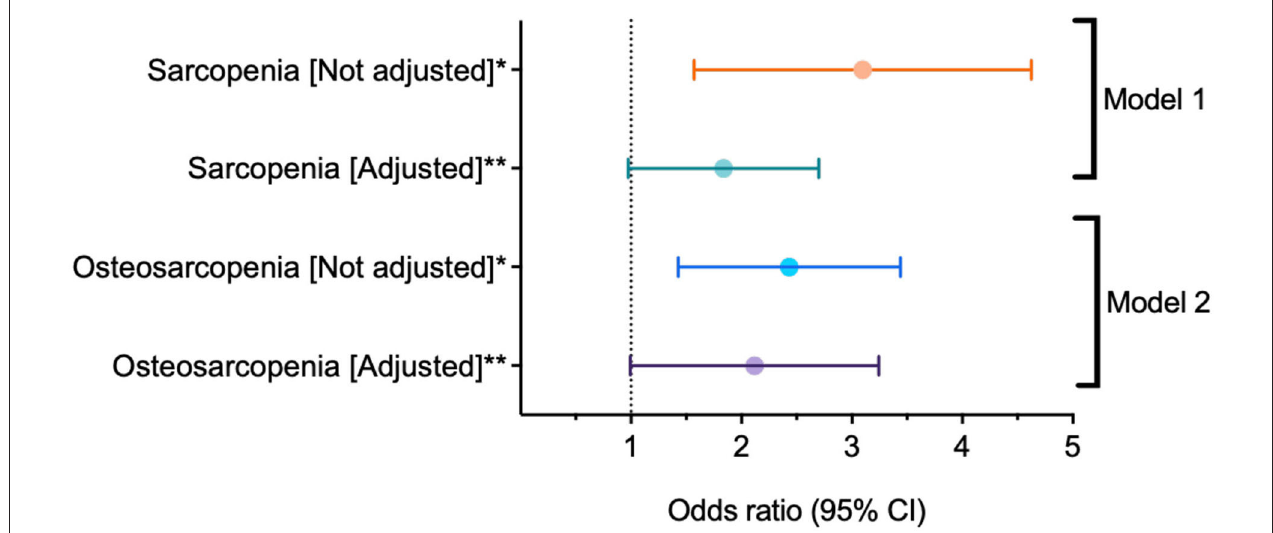
FIGURE 2 | Logistic regression between sarcopenia, osteosarcopenia, and functional disability. CI, Confidence intervals. * p < 0.001; ** p < 0.05. Both models were adjusted by age, sex, polypharmacy, risk of malnutrition, and low physical activity.